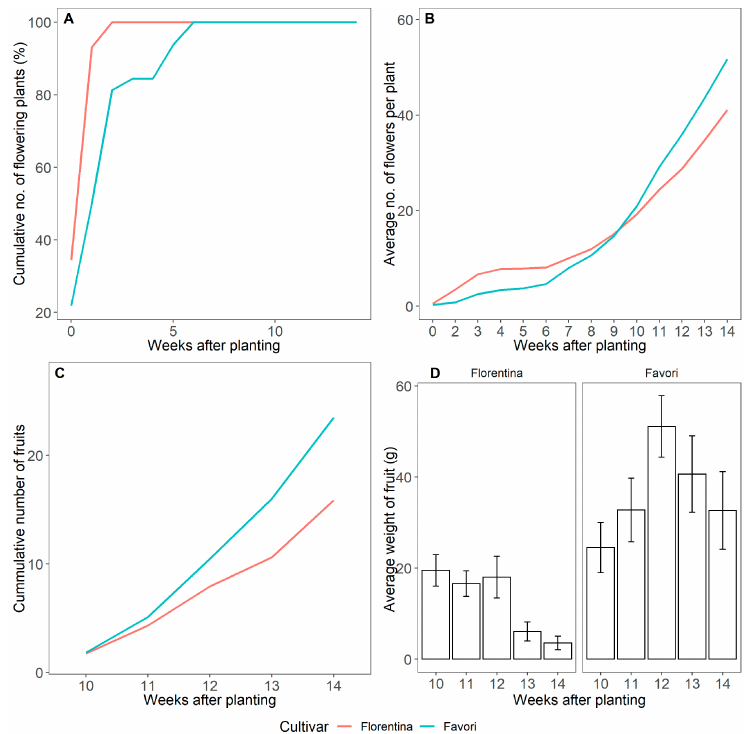
Figure 10. Cumulative number of plants that flowered (%) ( A ), cumulative number of flowers per plant ( B ), cumulative number of fruits collected ( C ), and average weight of the total number of fruits collected on the given week with the error bars representing the standard error ( D ) over the course of 14 weeks at 20 ◦ C under LD condition for ‘Florentina’ and